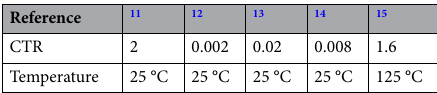
Table 1. Recently published optocouplers.